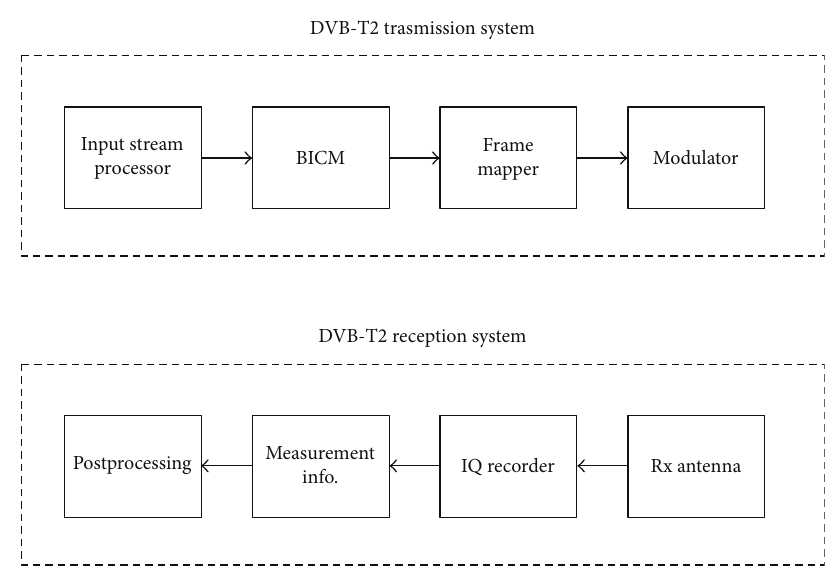
Figure 2: Block diagram of DVB-T2 transmission and reception systems.